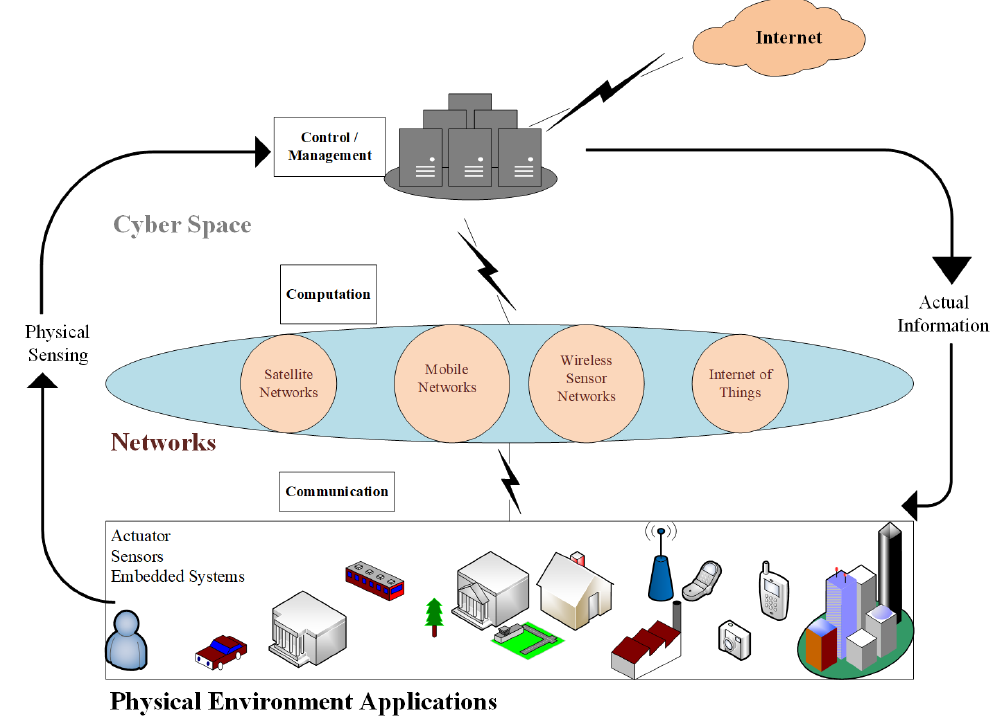
Figure 4. A cyber physical system architecture.